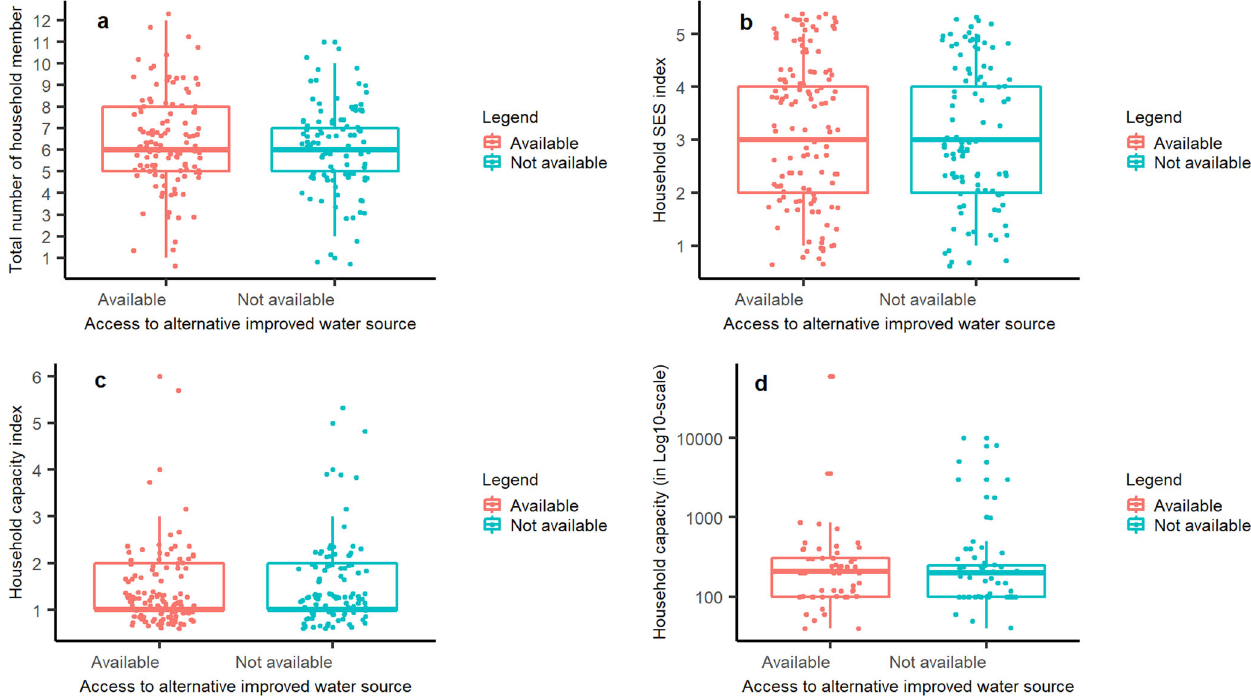
Fig. 2 Boxplots showing household characteristics by access to alternative improved water sources. Separate graphs are presented for different household characteristics: a total number of household members. b household socio-economic status characterised by an SES index. c household capacity index. d household rainwater storage capacity in Log10-scale. The bottom and top of the box are the 25th and 75th percentiles respectively, whilst the thick line that divides the box represents the median value; the superimposed coloured dots show individual households.